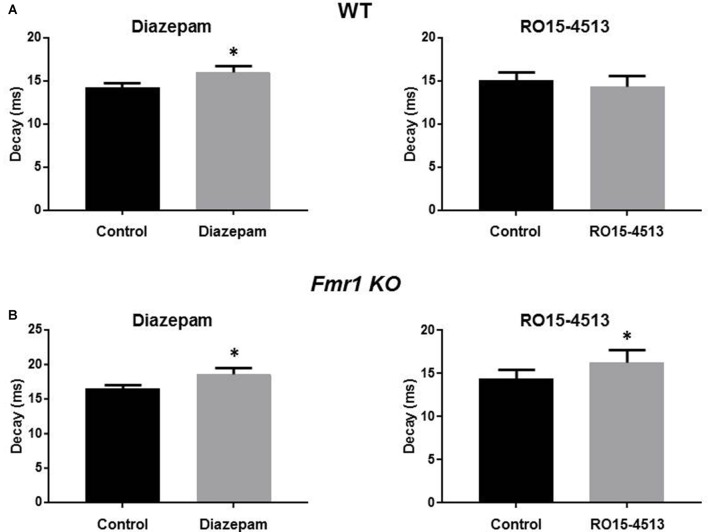
Modulation of DGGC IPSCs by benzodiazepines. Recordings were made from DGGCs in hippocampal slices from p21-35 WT, or Fmr1 KO mice. Bar graphs show the effects of acute (10 min) exposures to diazepam (left column) or Ro15-4513 (right column) applied to slices from (A) wild-type (n = 6) and (B)
Fmr1 KO (n = 7) mice. See text for p values.